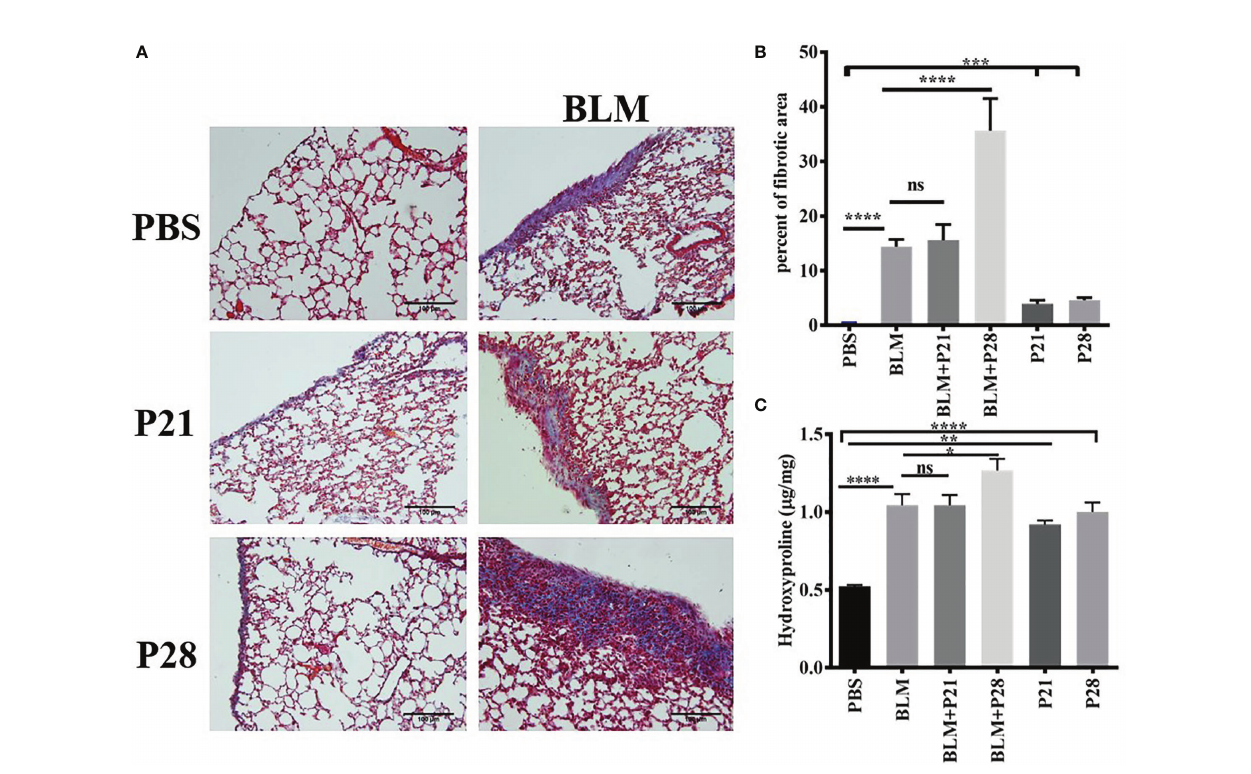
FIGURE 1 | Progesterone aggravates fi brosis in lung tissue. Bleomycin - treated mice received progesterone simultaneously or one week after initiation of bleomycin injection. On day 29 mice were deeply anesthetized and lungs were excised for pathologic and hydroxyproline assessment. (A) Masson trichrome staining of the lungs. 4 µm sections of paraf fi n embedded left lungs were stained with Masson trichrome and examined under light microscope. Original magni fi cation = 200X. Scale = 100 m m (B) Quantitative Lung fi brosis. Photographs of ten random fi elds were taken for each lung slide and then percentage of fi brosis calculated for each lung by ImageJ software. (C) Lung hydroxyproline content. Excised lower lobe of right lungs were hydrolyzed with HCl then hydroxyproline contents were measured in tissue hydrolysis. Results represented as mean ± SEM, n = 10 mice in each group. Data were analyzed with One – way ANOVA, Tukey multiple comparisons test. BLM, Bleomycin; P, Progesterone; ns, non - signi fi cant, **** = P < 0.0001, *** = P < 0.001, ** = P < 0.01, * = P <